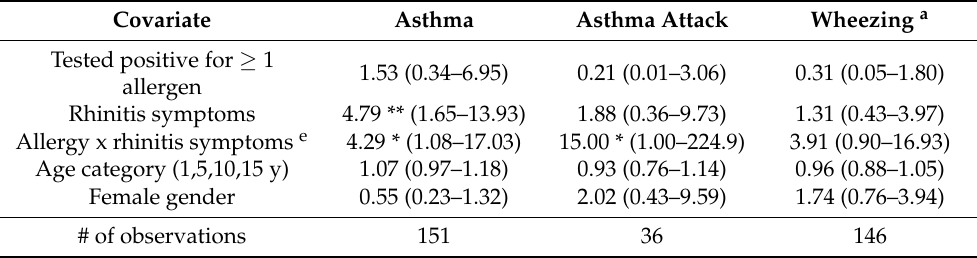
Table 6. Multivariate analysis. Age and gender-adjusted odds ratios (95% confidence interval) of asthma prevalence, asthma attack, and wheezing with respect to comorbid allergic conditions.